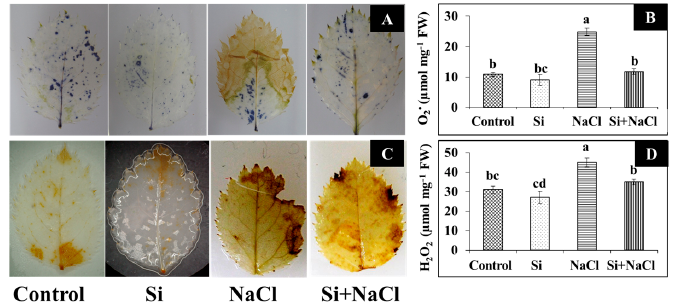
Figure 4. Histochemical localization ( A , C ) and content ( B , D ) of O 2 − and H 2 O 2 in the leaves of Rosa hybrida ‘Rock Fire’, respectively, during salt stress and Si treatments. Blue spots indicate the O 2 − localized ( A ) and brown spots indicate the H 2 O 2 ( C ) in the leaves. Data are the mean ± SD from three replicates. Different letters indicate that treatments are significantly different at p ≤ 0.05.